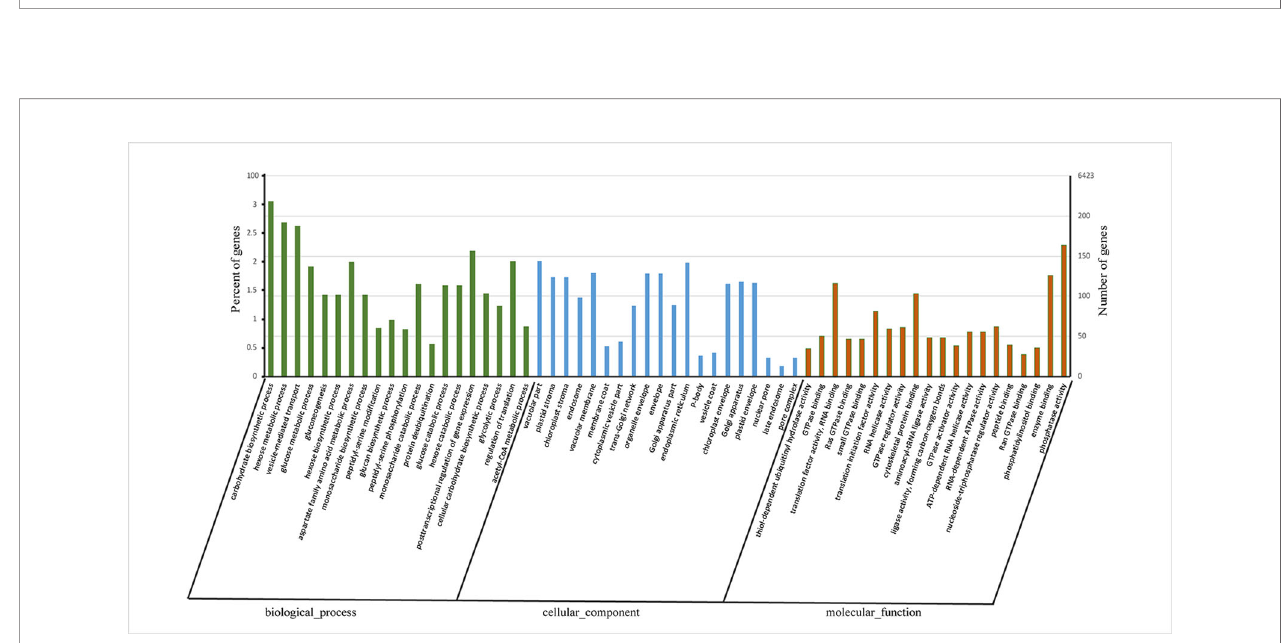
FIGURE 3 | Histogram showing gene ontology (GO) terms in alternative polyadenylation (APA) genes at enrichment signi fi cance (qvalue < 0.001 and qvalue top 20 of each category). The X-axis represents GO terms under biological process, cellular component and molecular function. The Y-axis represents enrichment ratio of APA genes.